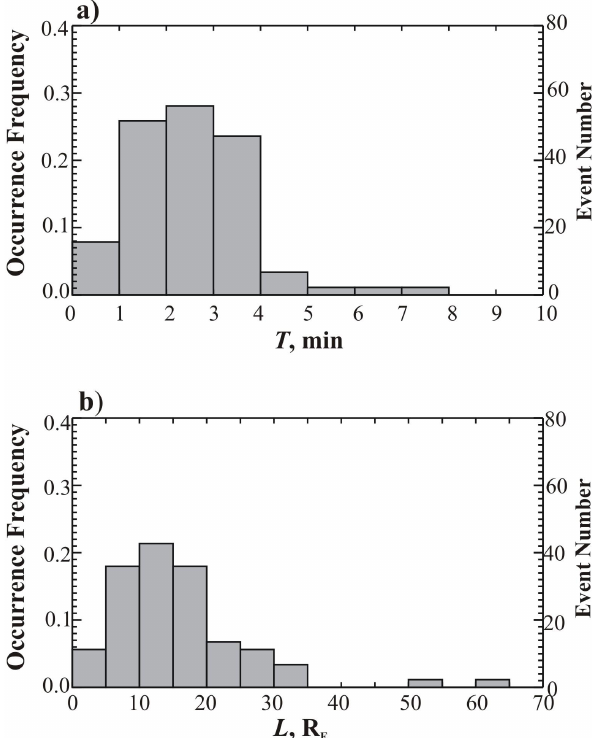
Fig. 10. Statistical distributions of wavy fluctuations associated with high velocity field-aligned ions: (a) periods T and (b) wave- lengths L .